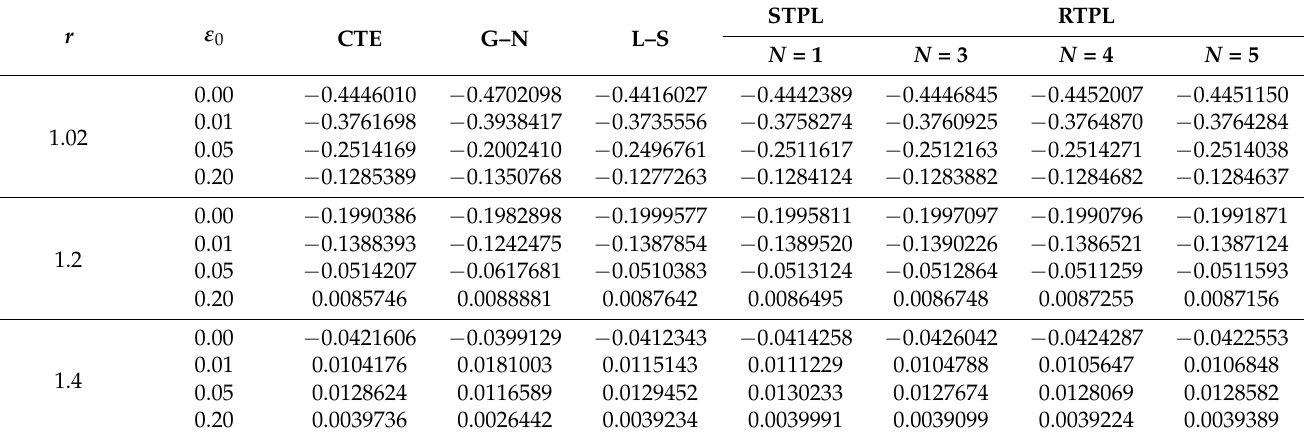
Table 12. Different thermoelasticity theories with a range of r values show the effects of dimensionless electric permittivity ε 0 on radial displacement u .